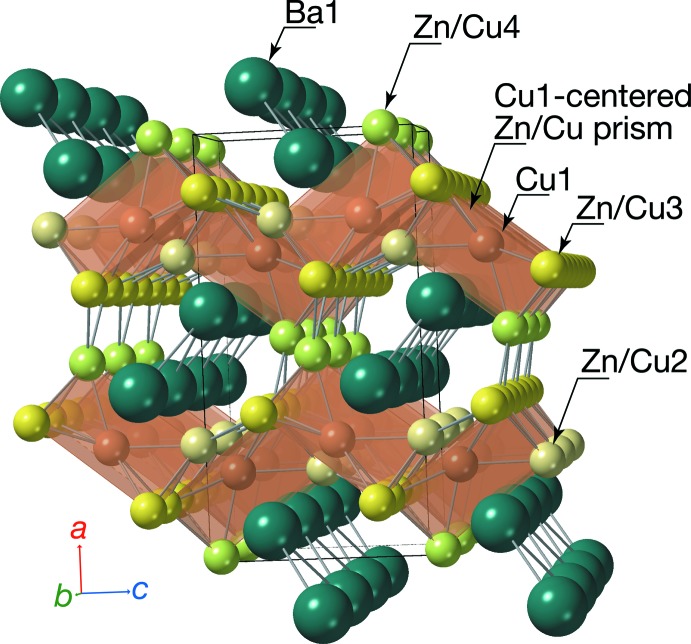
Crystal structure of BaCu2.6Zn2.4 illustrated with the Cu1-centered Zn/Cu trigonal prisms.